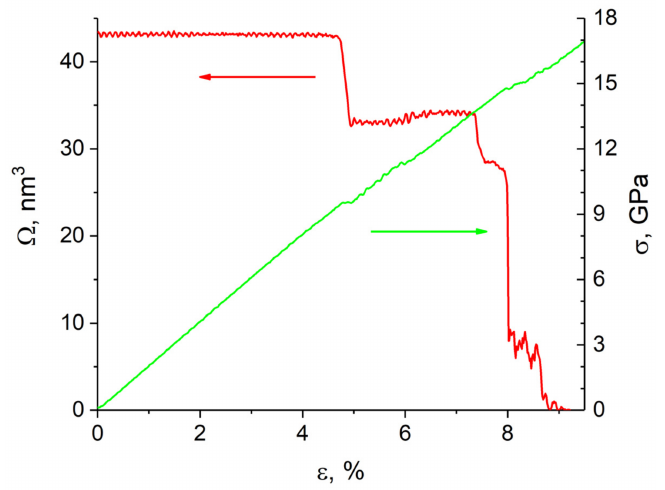
Figure 9. Variation of stress intensity of the sample (green curve) and crack volume (red curve) versus strain degree for sample with (011)[011] crack. Axis corresponding to each curve is pointed by an